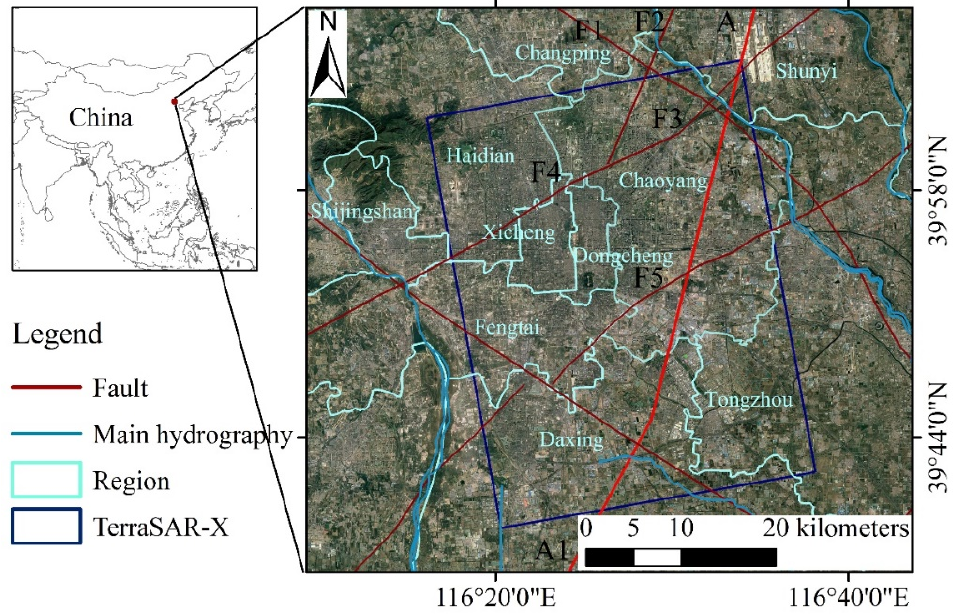
Figure 1. The study area and the coverage of InSAR data. Red lines represent major fault lines. The location of faults are derived from [49]. The hydrogeological profile used is shown in Figure 2 (A-A1). The background is a satellite image from Google Earth.